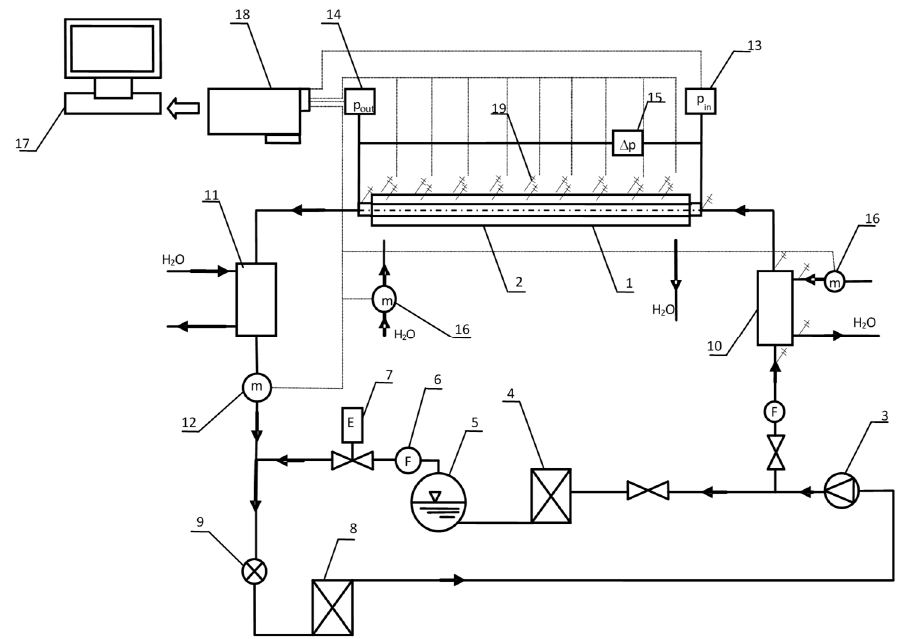
Figure 3. Schematic diagram of the experimental facility: (1) tube minichannel, (2) water channel, (3) compressor, (4) fan refrigerator, (5) filter, (6) refrigerant liquid tank, (7) electromagnetic valve, (8) condenser, (9) expansion valve, (10) preheat exchanger, (11) heat exchanger, (12) refrigerant mass flow meter, (13–15) pressure measurement, (16) water mass flow meter, (17) computer, (18) data acquisition system, and (19) thermocouples.